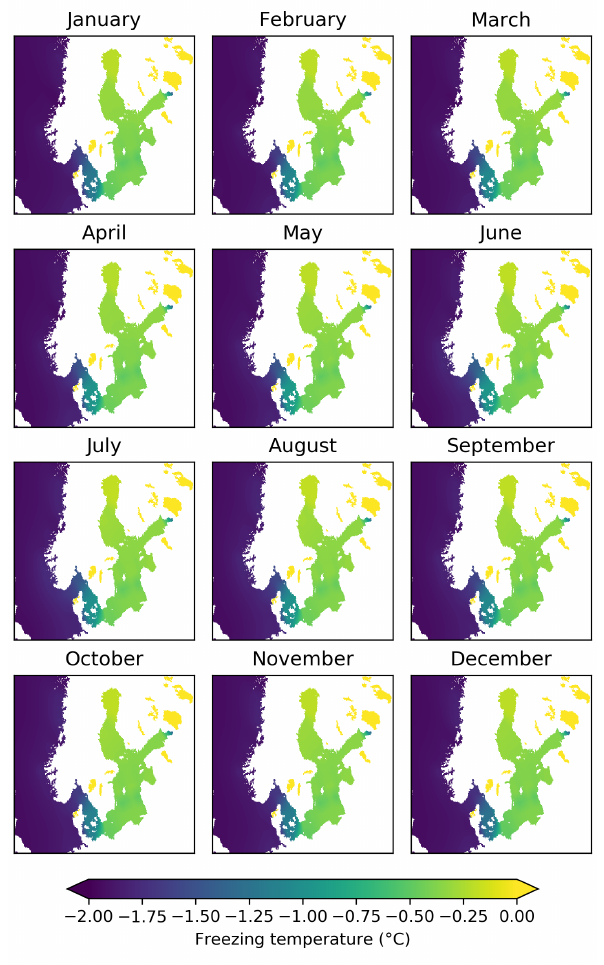
Figure 5. Monthly freezing temperature climatology for the Baltic Sea and part of the North Sea. Variations between months are small with the largest changes occurring in the Kattegat and surrounding